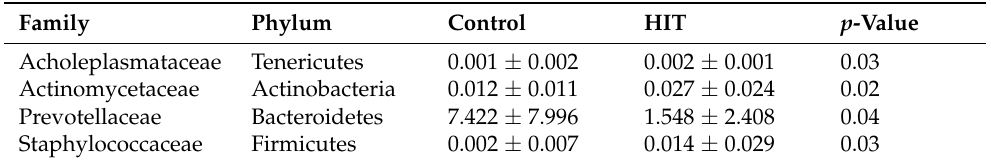
Table 3. Differences in the relative abundance (%) of bacterial families between the control and HIT groups. Data are presented as average ±